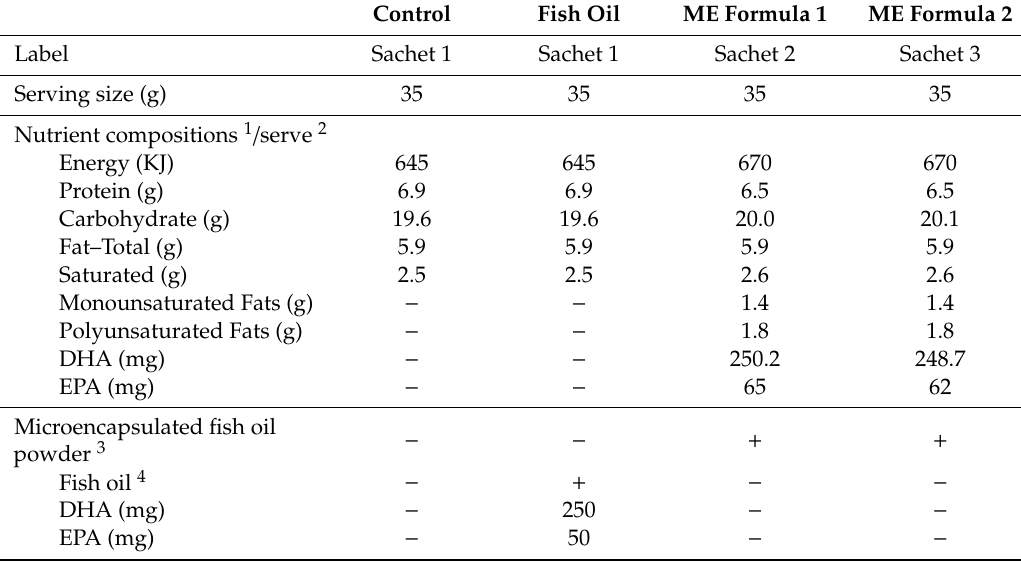
Table 1. Nutrition Information of